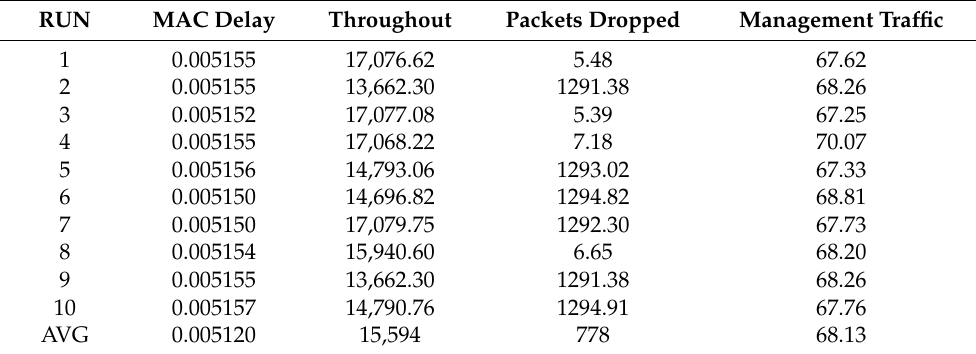
Table 4. Simple Scenario